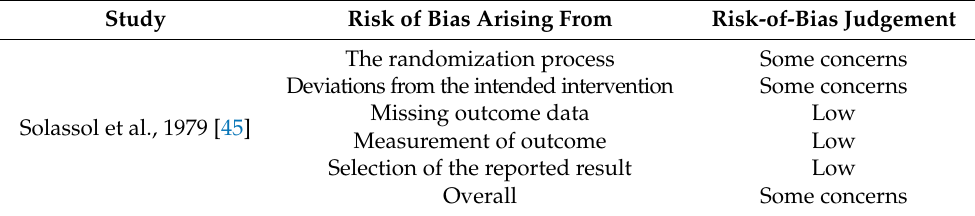
Table 5. Quality assessment of randomized controlled trial using the revised Cochrane Risk of Bias